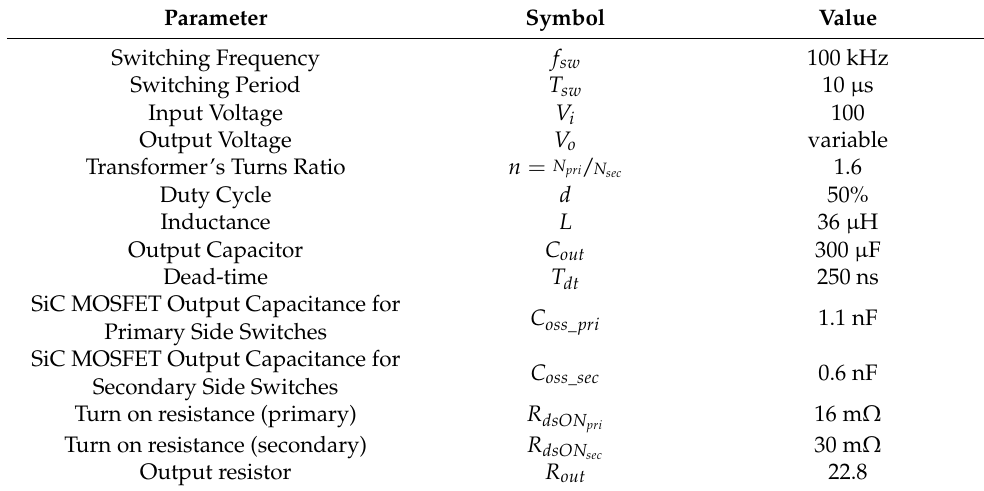
Table 1. DAB converter (TIDA-010054)